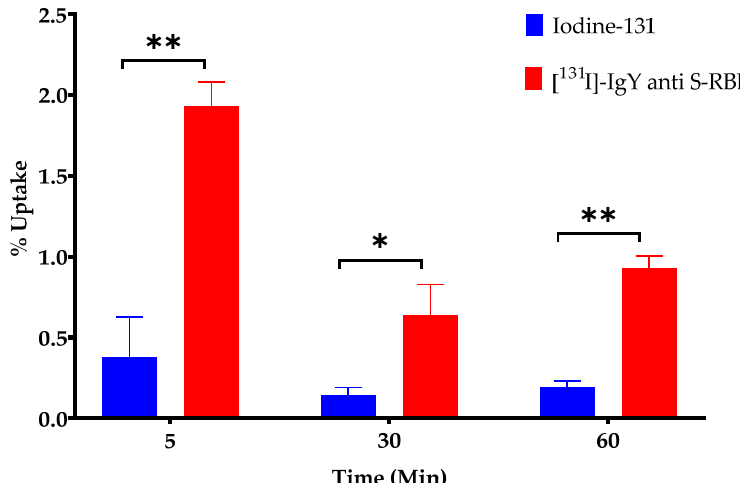
Figure 6. Cellular uptake of [ 131 I]-IgY anti-RBD spike SARS-CoV-2 and iodine-131 (control) in MRC-5 cell line at 5, 30, and 60 min ( n = 5). * p < 0.05, ** p < 0.01 compared with control group (iodine-131).